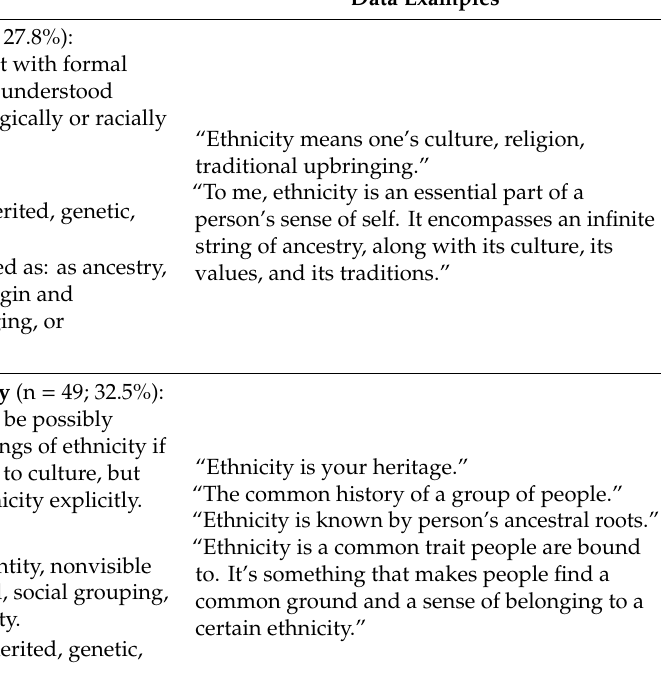
Table 6. Examination of congruence between colloquial meanings and social science definitions of ethnicity. Congruency Category Data